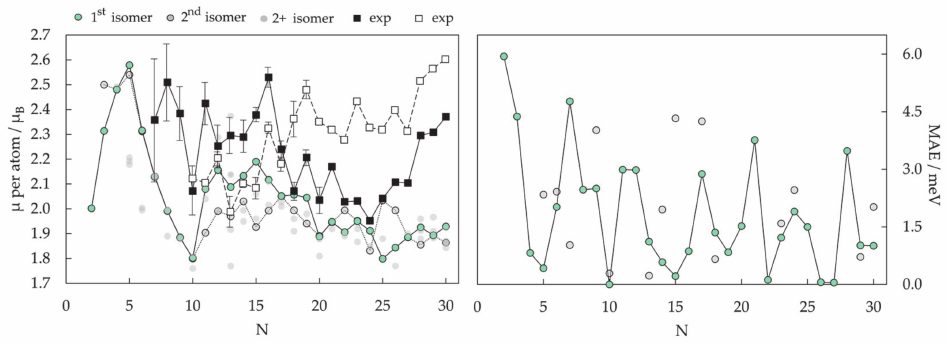
Figure 5. Experimental data are taken from Knickelbein (2006) [270] ( (cid:4) ) and Xu (2005) [271] ( (cid:3) ), DFT data from Farkaš (2020) [239]. Legend is the same for both graphs.